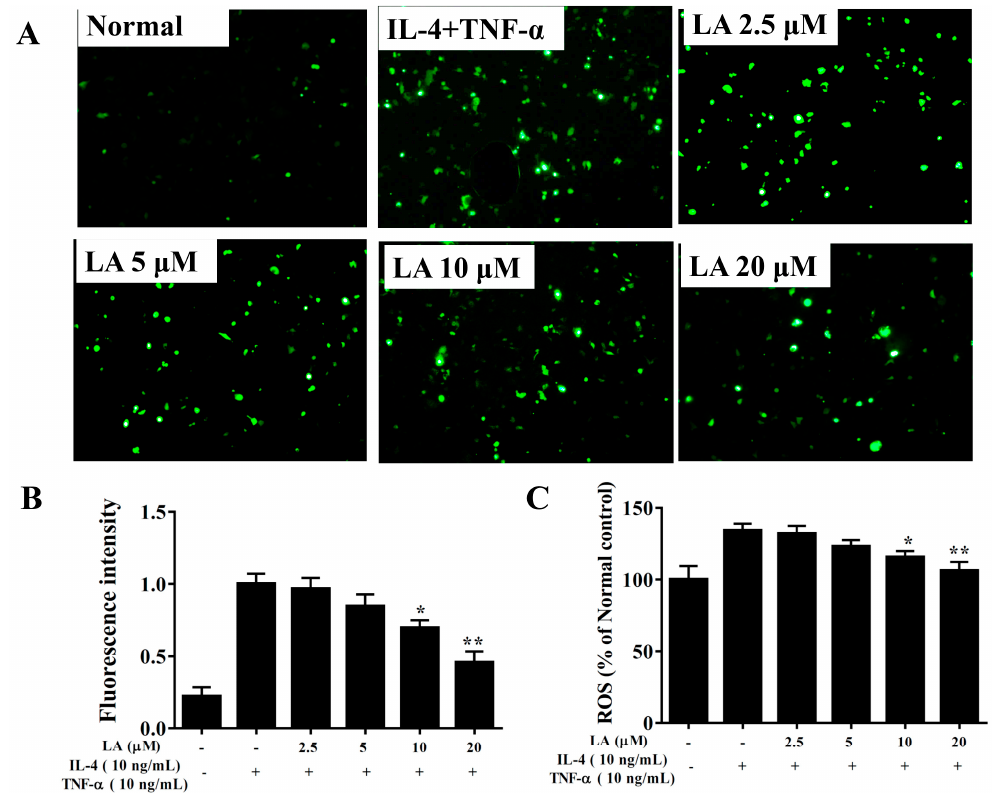
Figure 11. Effects of licochalcone A (LA) on ROS production in activated BEAS ‐ 2B cells. ( A ) Fluorescence microscopy images of intracellular ROS. ( B ) Fluorescence intensity of intracellular ROS. ( C ) Percentages of ROS detected in TNF ‐α /IL ‐ 4 ‐ activated BEAS ‐ 2B cells in the absence or presence of LA compared to untreated cells (Normal). Three independent experiments were analyzed, and data were presented as mean ± SEM. * P < 0.05, ** P < 0.01 compared to BEAS ‐ 2B cells stimulated with TNF ‐α and IL ‐ 4.